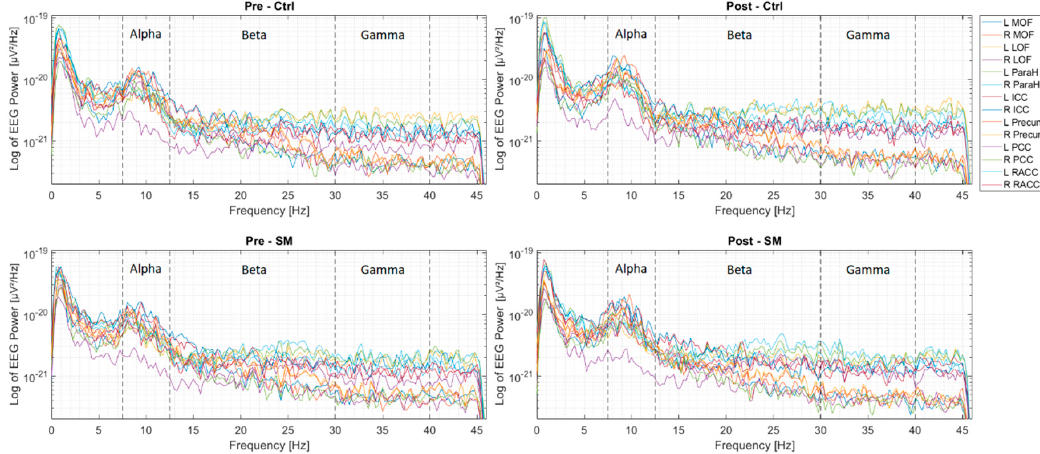
Figure 4. The four plots illustrate the power spectral density (PSD) estimations for the 14 regions within the default mode network (DMN) averaged across subjects, pre control session, plot (1); post control session, plot (2); pre SM session, plot (3), and post SM session, plot (4). Alpha, beta, and gamma frequency bands were specified in each plot. Left medial orbitofrontal (L MOF), right medial orbitofrontal (R MOF), left lateral orbitofrontal (L LOF), right lateral orbitofrontal (R LOF), left parahippocampal (L ParaH), right parahippocampal (R ParaH), left isthmus cingulate cortex (L ICC), right isthmus cingulate cortex (R ICC), left precuneus (L Precun), right precuneus (R Precun), left posterior cingulate Cortex (L PCC), right posterior cingulate cortex (R PCC), left rostral anterior cingulate cortex (L RACC), and right rostral anterior cingulate cortex (R RACC).